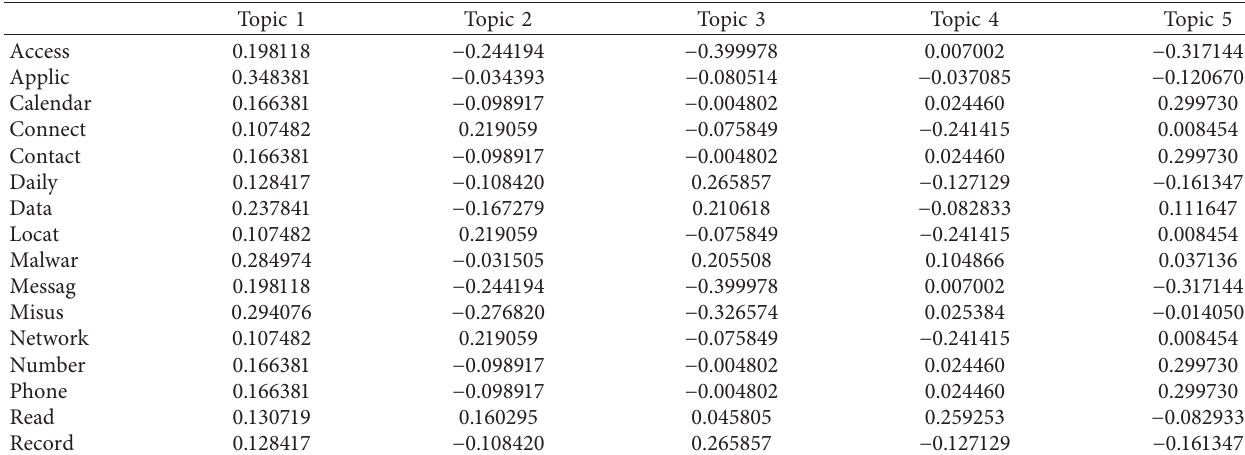
Table 7: Term-loading with five latent